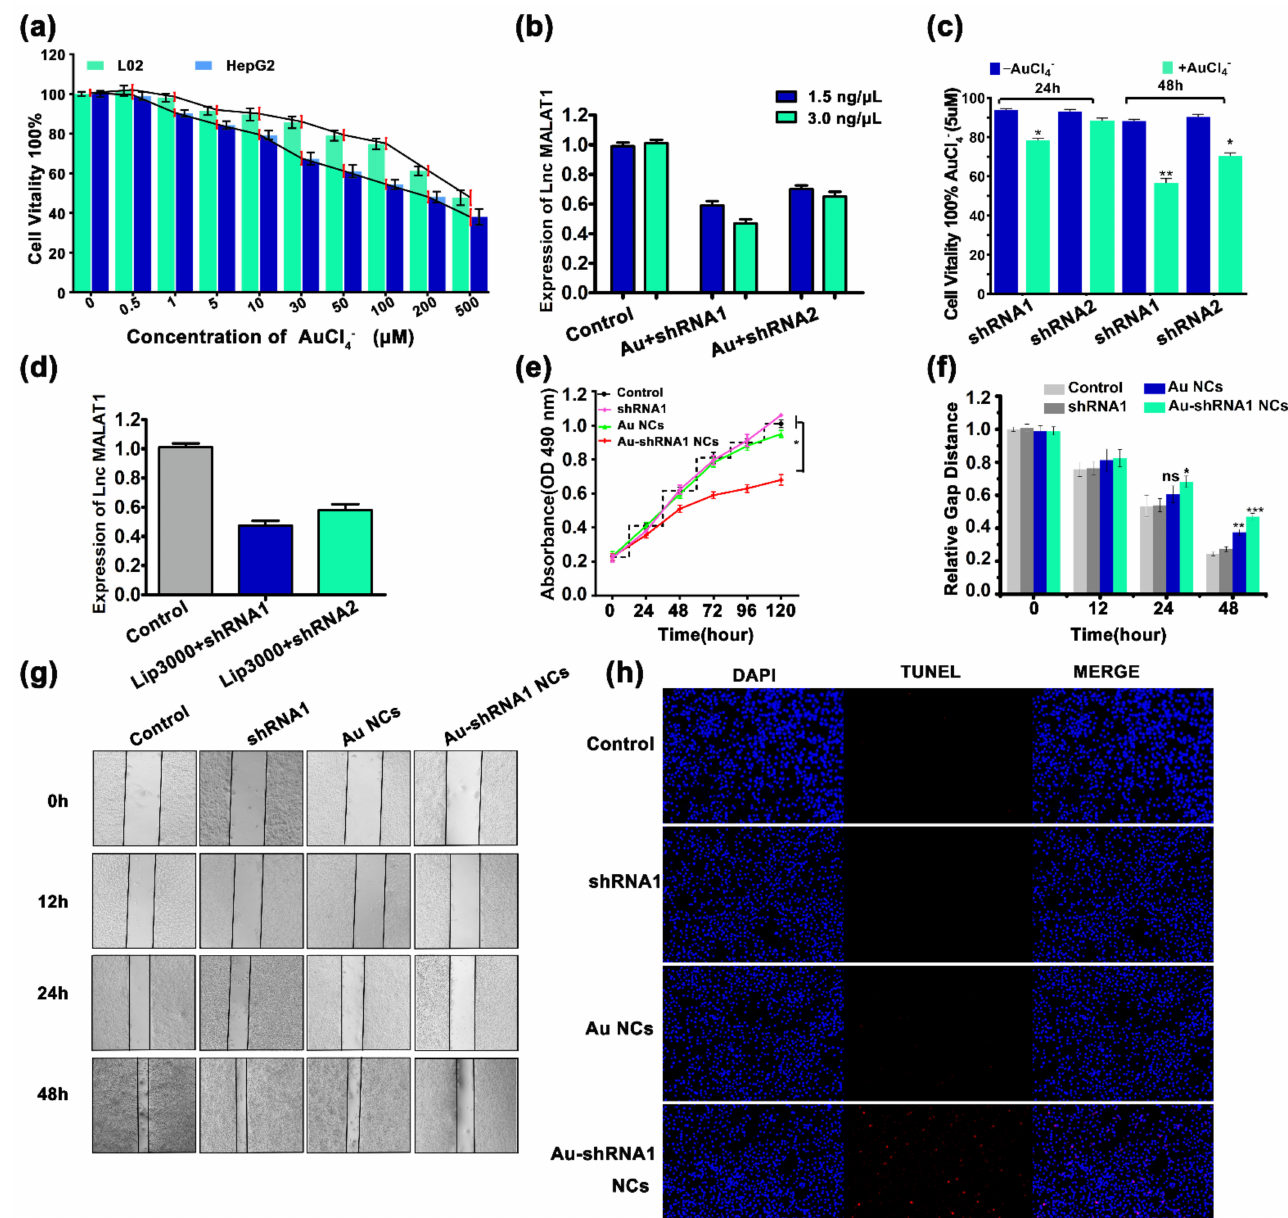
Figure 3. Biochemical characteristics of bio-self-assembled Au–shRNA NCs. ( a ) MTT cell viability and toxicity analysis of HepG2 and L02 cells with HAuCl 4 . ( b ) MTT assay of HepG2 cells with Au–shRNA NCs generated with different concentrations of shRNA1 and shRNA2 (normalized to unprocessed cells). ( c ) The inhibitory effects of shRNA1 and shRNA2 with (green) and without (blue) gold salt in HepG2 cells at 24/48 h treatment. ( d ) The ability of 3 ng/ µ L shRNA1 and shRNA2 to silence MALAT1 in HepG2 cells was examined by Lip 3000 transfection. ( e ) Long-term (5-day) MTT proliferation analysis of HepG2 cells under different conditions (ANOVA, * p < 0.05). Control group (unprocessed), shRNA1 group (shRNA1, 3 ng/ µ L), Au NCs group (HAuCl 4 , 5 µ M), and Au–shRNA1 NC group (shRNA1, 3 ng/ µ L; HAuCl 4 , 5 µ M). ( f , g ) The corresponding HepG2 cell scratch-healing experimental analysis and morphological images are also displayed. ** p < 0.01, *** p < 0.001. ( h ) HepG2 cells treated with shRNA1 with or without gold salt were analyzed by the TUNEL assay. The red color indicates cell apoptosis, and the blue color indicates HepG2 cell